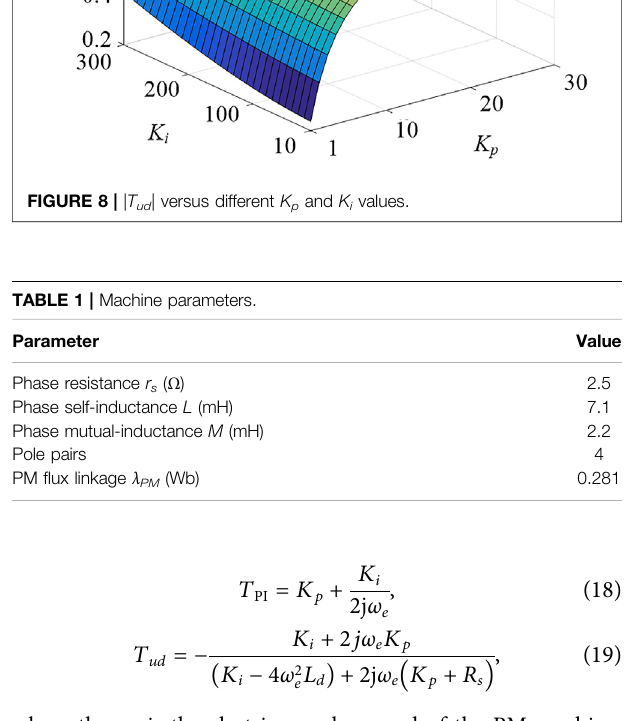
FIGURE 9 | Flow chart of HRC